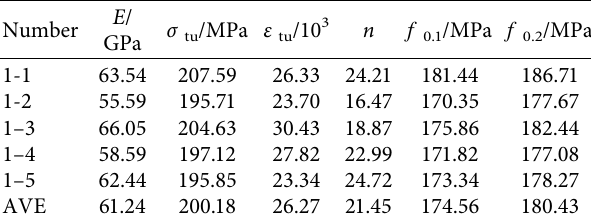
Table 1: Results of tensile